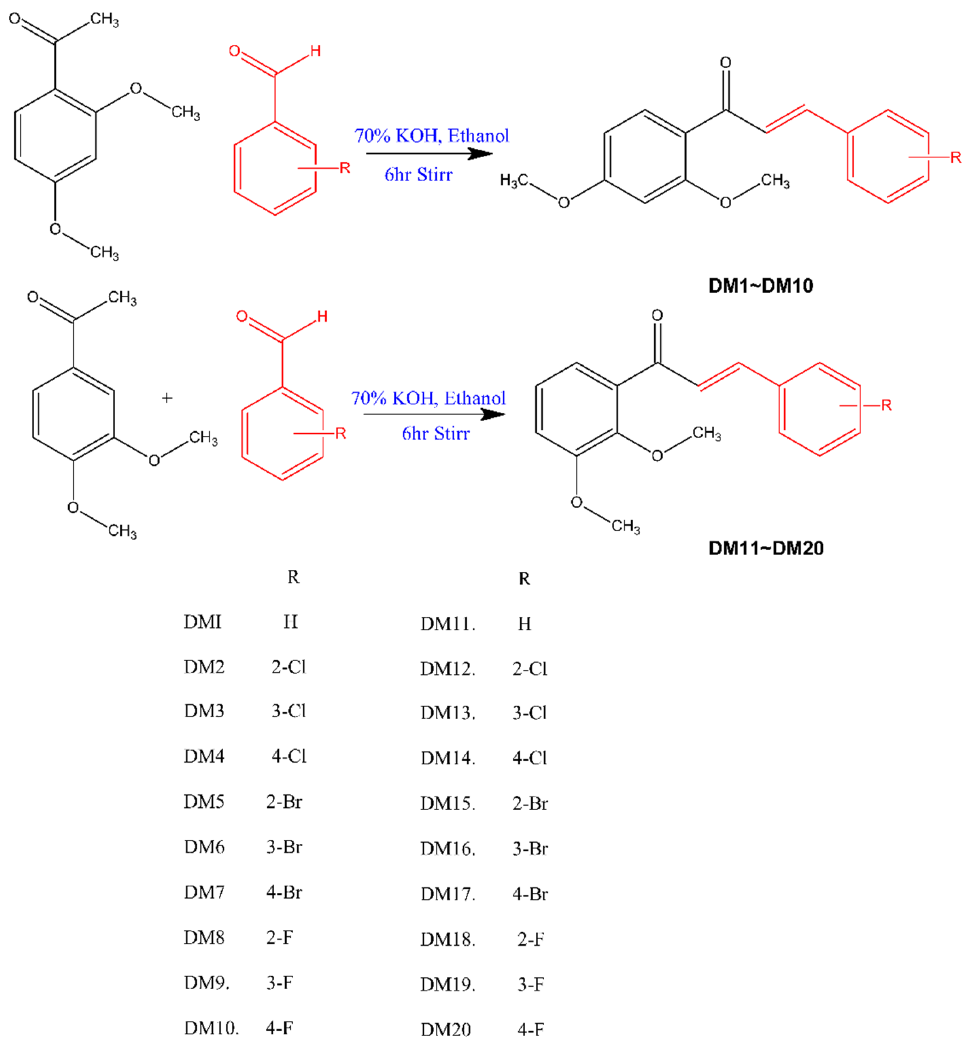
Figure 1. Synthetic route of dimethoxy halogenated chalcones.